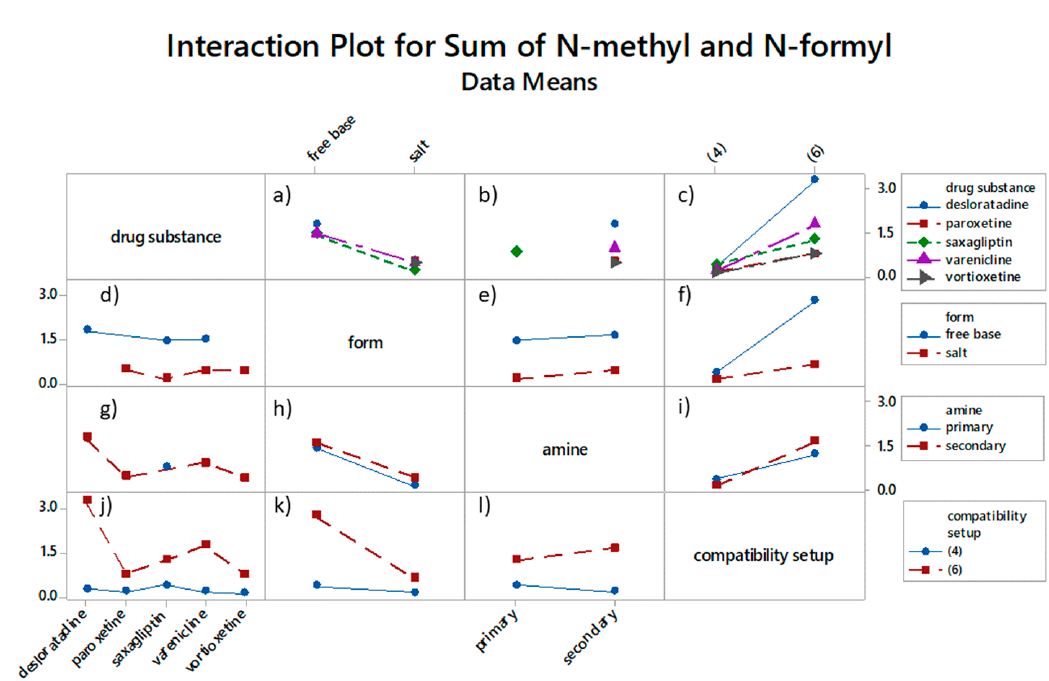
Figure 7. Interaction plot for sum of N -methyl and N -formyl impurities for multiple factors (grouped), based on data means. Data grouped by ‘drug substance’: ‘substance form’ on x axis ( a ), ‘type of amine’ on x axis ( b ), ‘compatibility setup’ on x axis ( c ); data grouped by ‘substance form’: drug substance on x axis ( d ), ‘type of amine’ on x axis ( e ), ‘compatibility setup’ on x axis ( f ); data grouped by ‘type of amine’: ‘drug substance’ on x axis ( g ), ‘substance form’ on x axis ( h ), ‘compatibility setup’ on x axis ( i ); data grouped by ‘compatibility setup’: drug substance on x axis ( j ), ‘substance form’ on x axis ( k ), ‘type of amine’ on x axis ( l ). Only tertiary design data from Table 6 is used for